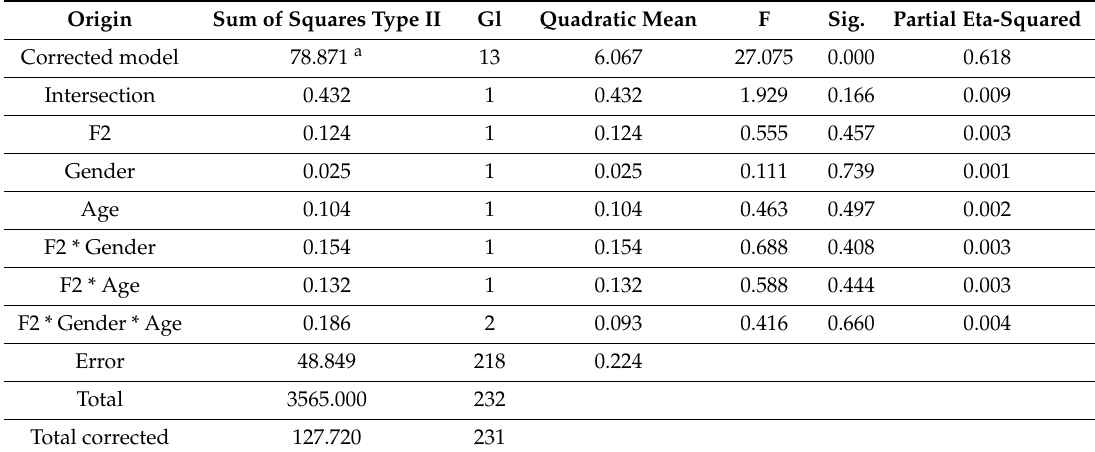
Table 7. Tests of the inter-subject e ff ects between F1 and F2 with covariables gender and